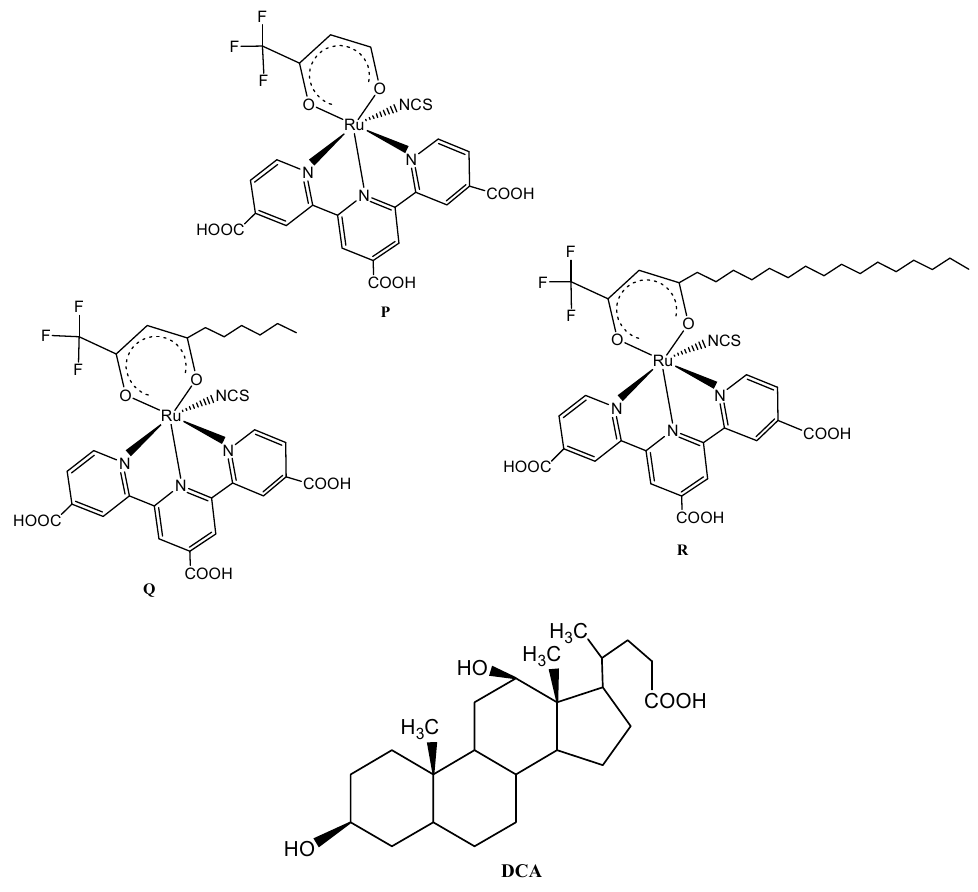
Figure 14. Molecular structures of Ru(II) terpyridyl complexes with/without bulky alkyl chains and deoxycholic